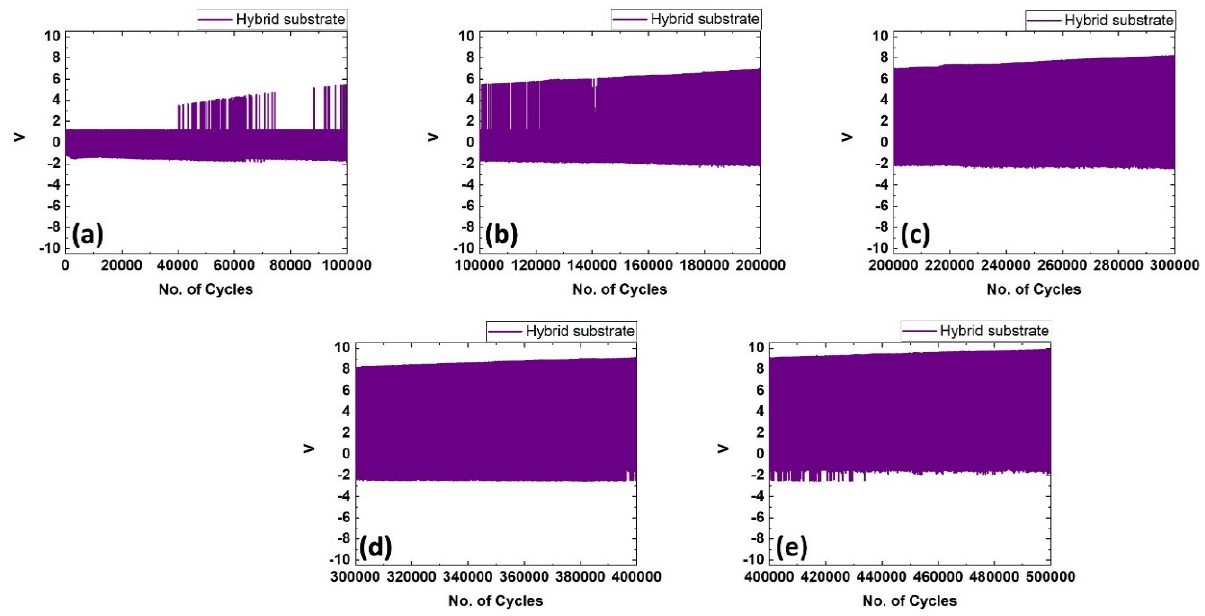
Figure 9. Piezoelectric energy-harvesting device cycles ( a – e ) output-voltages for number of cycles from 0 to 0.5 million .